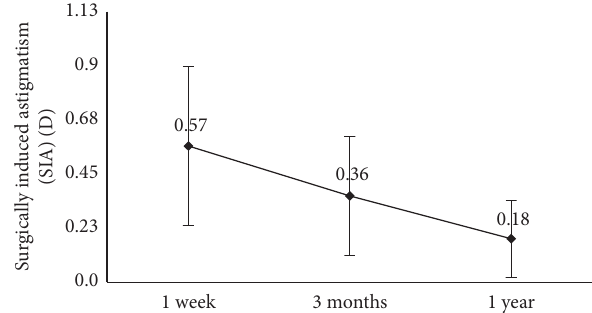
Figure 4: Variation in surgically induced astigmatism (SIA) during the follow-up period ( n � 144